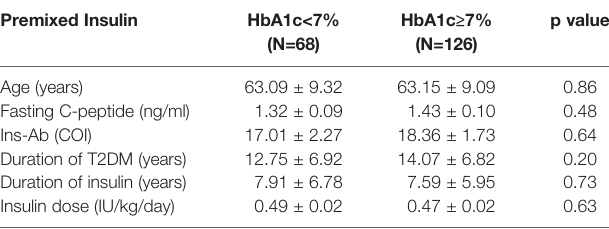
Data was shown as mean ± SD. HbA1c, glycated haemoglobin; Ins-Ab, insulin antibody; COI, OD/CO; OD, absorbance; CO, average absorbance of negative control; The reference range of normal values for antibody is <1